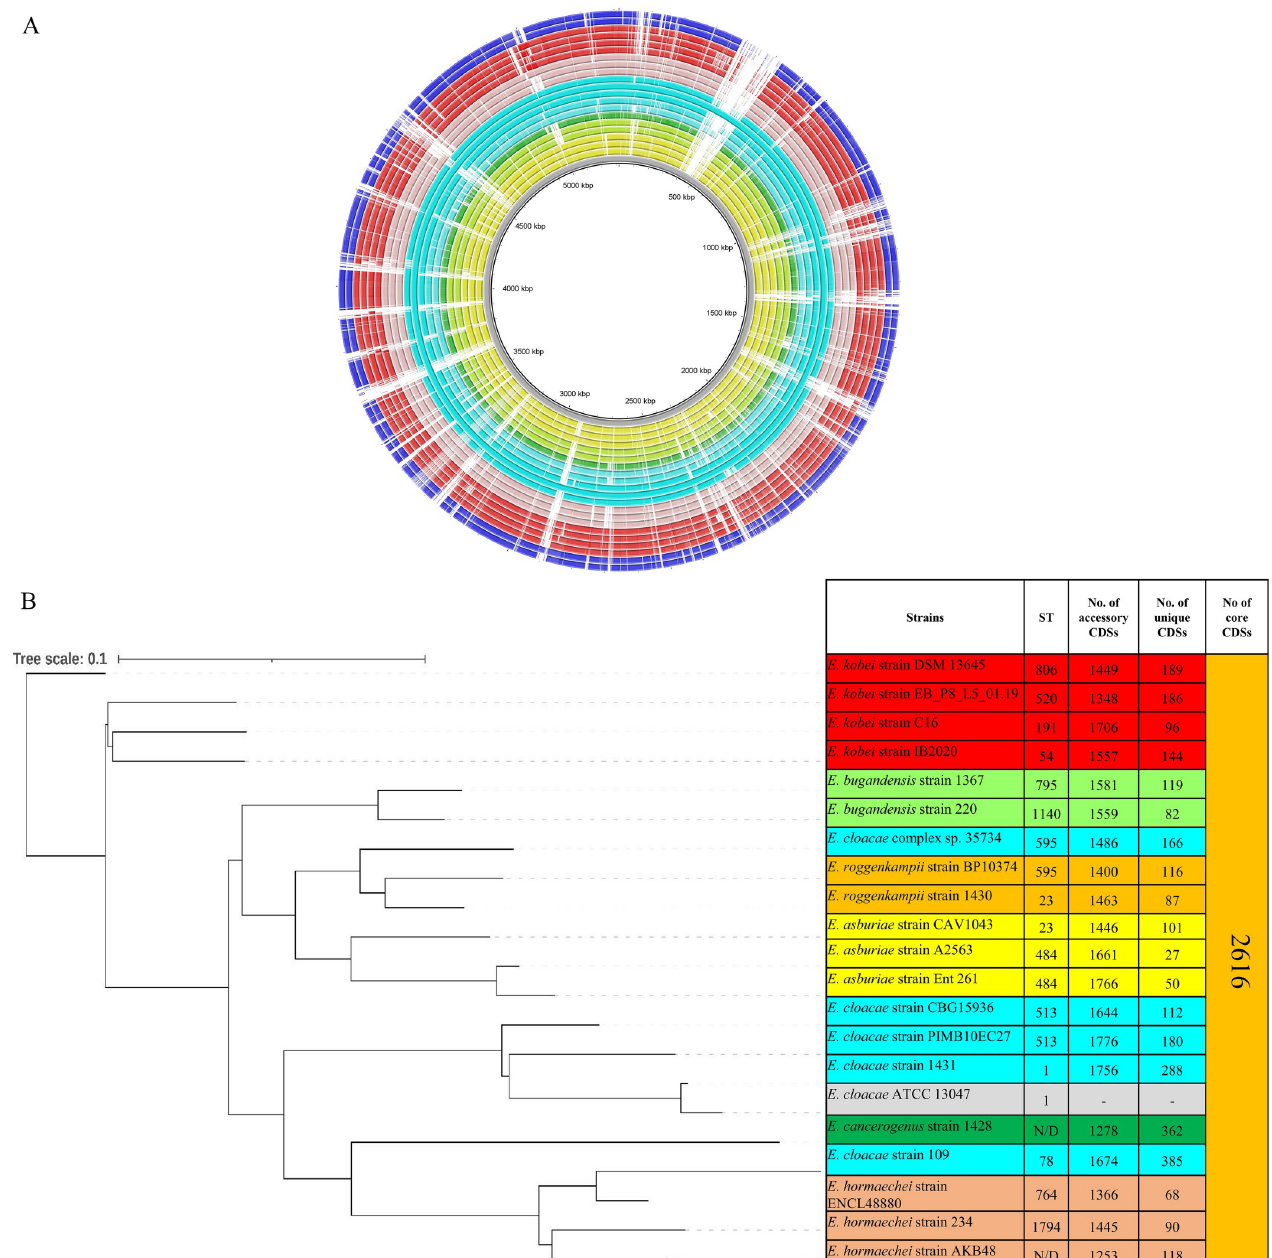
Fig 1. A. The whole genomic multiple sequence alignment of 20 different clinical Enterobacter spp. isolates. The results showed their high similarity. B. The phylogenetic dendrogram based on cg-MLST using 1680 genes with � 95% sequence similarity. The results indicated a close ancestral relationship between different members of Enterobacter spp. A number of 2616 core coding sequences were retrieved from their genome with � 50% similarity.